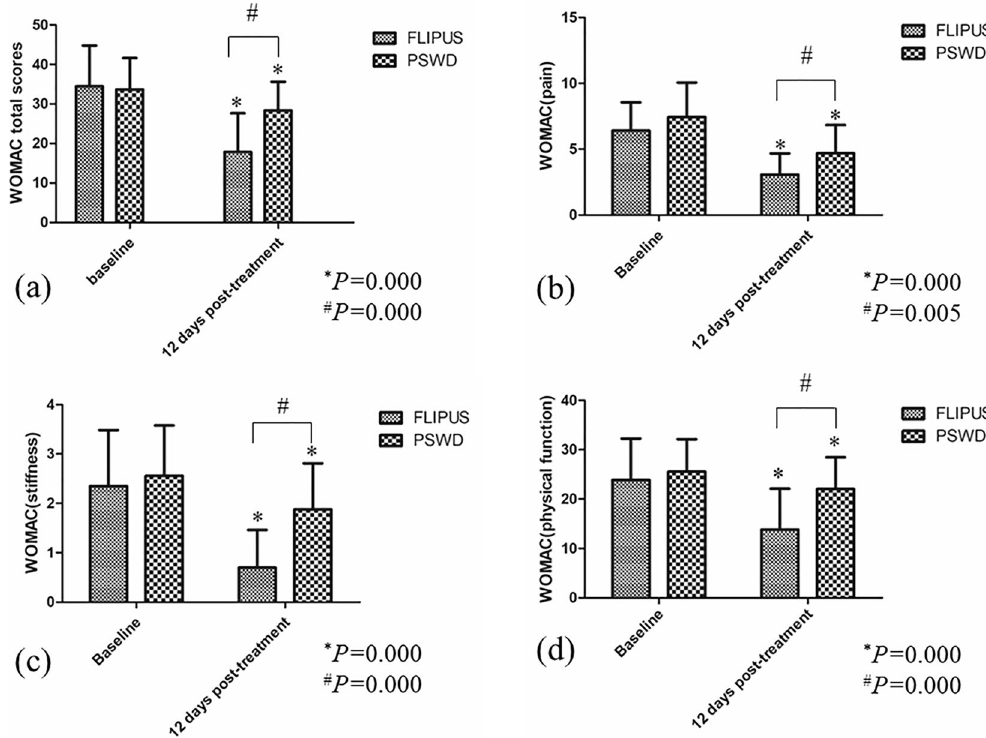
Figure 3. Primary efficacy measures after 12 days of treatment. ( a ) WOMAC total score, ( b ) pain subscore, ( c ) joint stiffness subscore, and ( d ) physical function subscore. Error bars indicate standard deviations. *indicates a significant within-group difference between pretreatment scores. # indicates a significant between-group difference after 12 days of treatment.